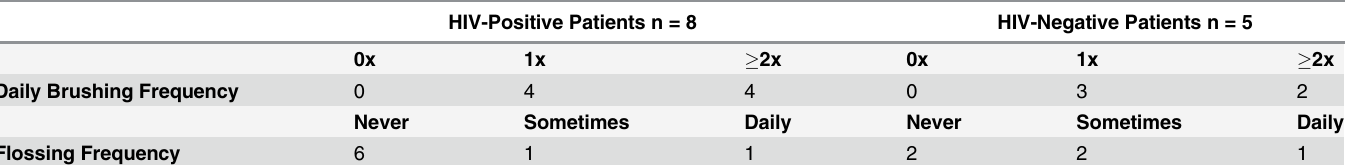
Table 3. Daily Dental